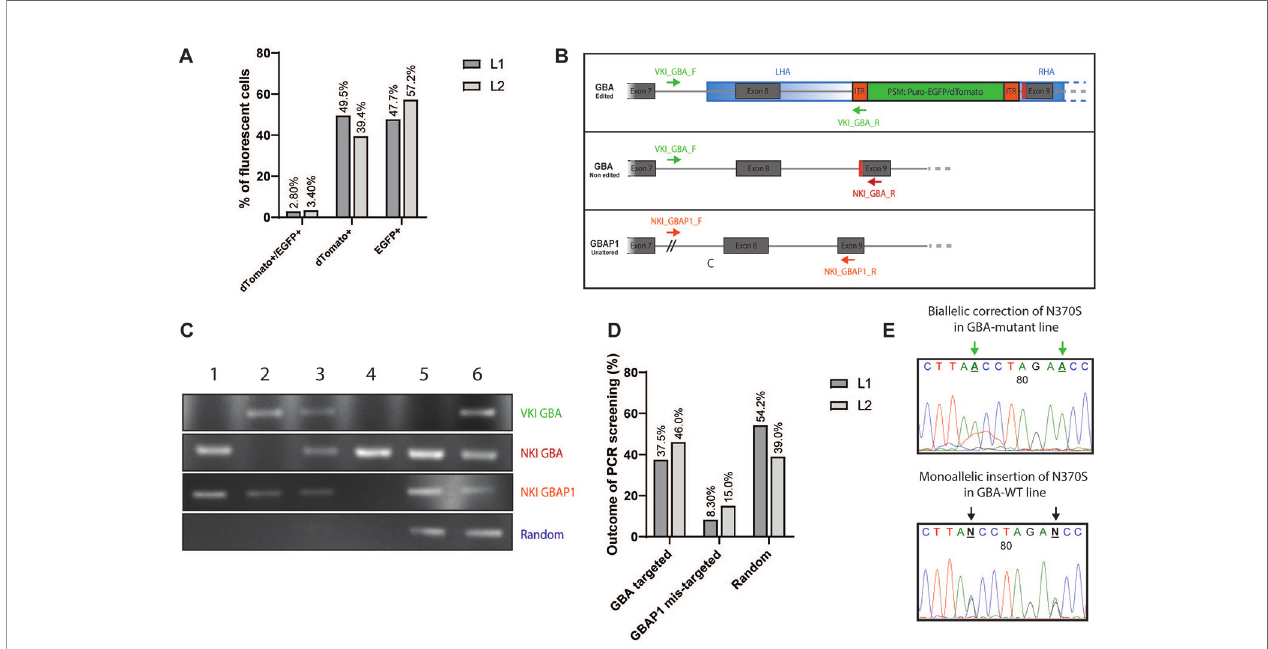
FIGURE 2 | Fluorescent and PCR-based screening of iPSC clones. (A) Graphic representation of the outcome of the fl uorescent-based screening. Results are expressed in % of all fl uorescent colonies (dTomato+, EGFP+, and double-positive). Dark grey: line L1 to correct (739 colonies in total). Light grey: line L2 to insert (522 colonies in total). (B) Visualization of the PCR-based screening strategy for the validation of the knock-in (KI). Three editing status need to be screened: correct editing of GBA (upper panel, VKI_GBA primers), no editing of GBA (middle panel, NKI_GBA primers), no targeting of GBAP1 (lower panel, NKI_GBAP1). (C) Example panel of the different editing status. First lane: Ampli fi cation with VKI_GBA primers; second lane: Ampli fi cation with NKI_GBA primers; third lane: Ampli fi cation with NKI_GBAP1 primers; fourth lane: Ampli fi cation with VKI_LHA primers. Clone 1: unedited; Clone 2: correct biallelic targeting of GBA ; Clone 3: correct monoallelic targeting of GBA ; Clone 4: mis-targeting of GBAP1 ; Clone 5: random integration LHA; Clone 6: monoallelic targeting of GBA and random integration of LHA. (D) Graphic representation of the outcome of the PCR-based screening. Results are expressed in % of all clones entering the PCR-based screening (24 clones for L1; 13 clones for L2). Random accounts for clones with random integration only or associated with correct targeting of GBA . Dark grey: line L1 to correct. Light grey: line L2 to insert. (E) DNA chromatograms of GBA sequence after gene editing. Change in the base to edit can be observed as well as the appearance of the TTAA motif after excision of the PSM. Here are examples of biallelic correction in L1 (homozygous for TTAA) and monoallelic insertion for L2 (heterozygous for